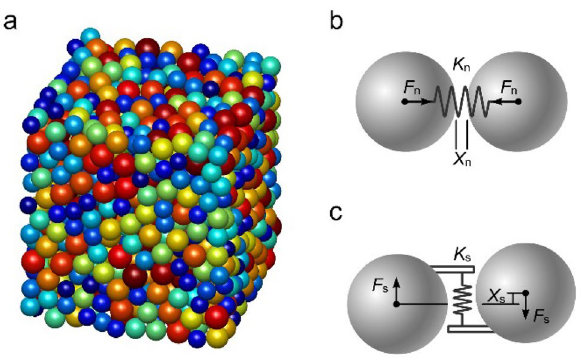
Figure 1. ( a ) A 3D discrete element model; ( b ) Normal spring force; ( c ) Shear spring